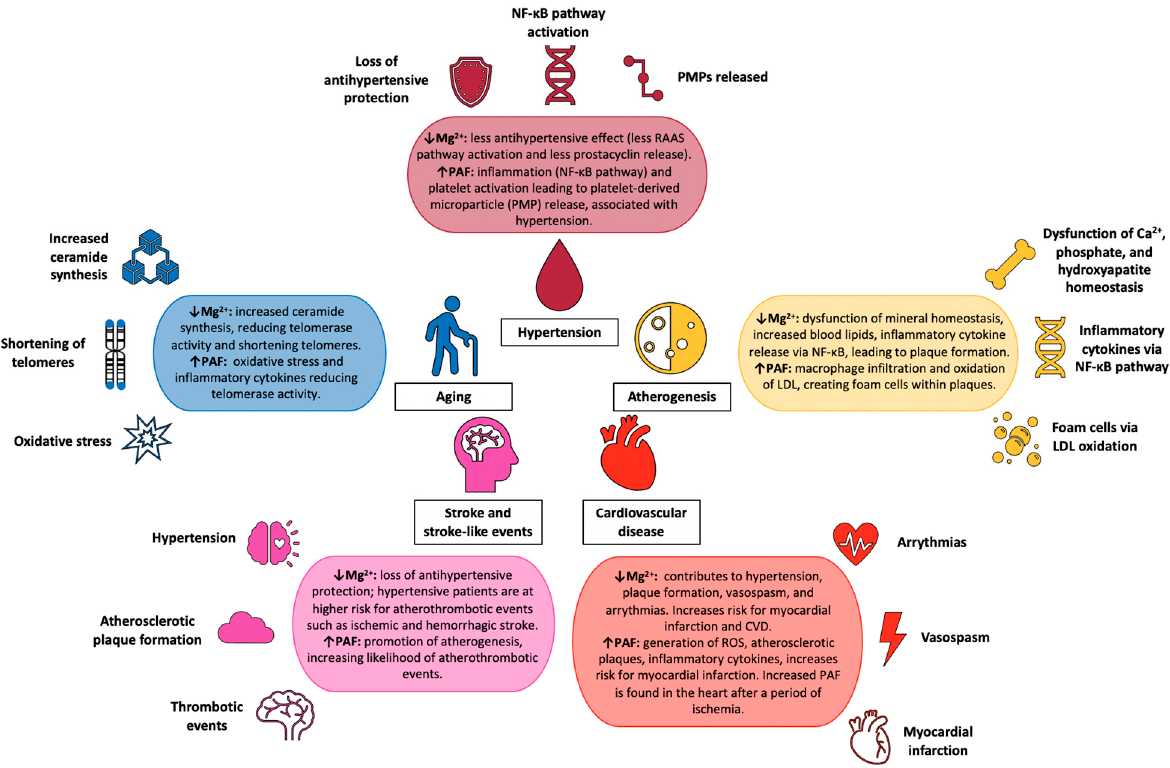
Figure 9. Effects of low magnesium and increased PAF on hypertension, atherogenesis, cardiovascular disease, stroke, and aging.